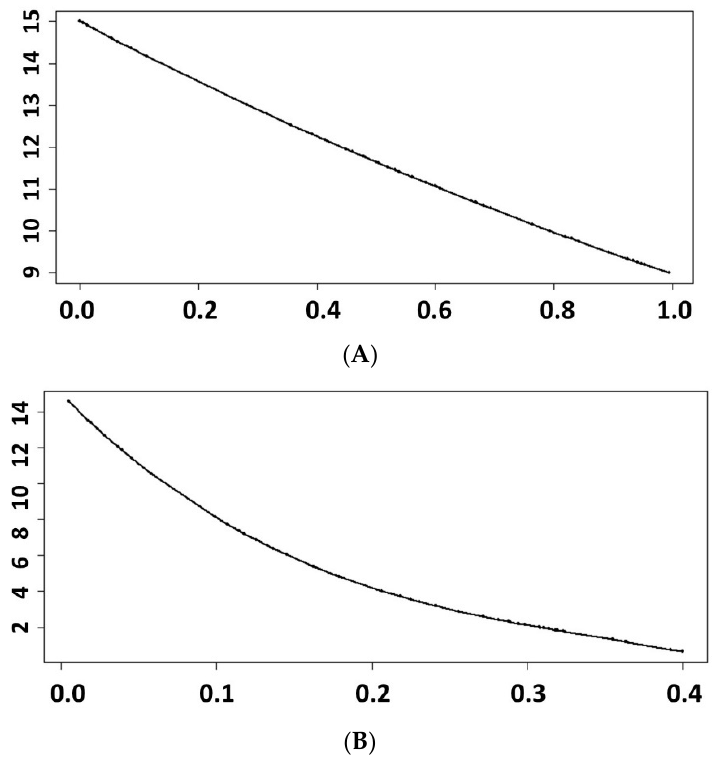
Figure 2. Plots of HV curves. ( A ) Vessel assisted at a distance. ( B ) Vessel in level